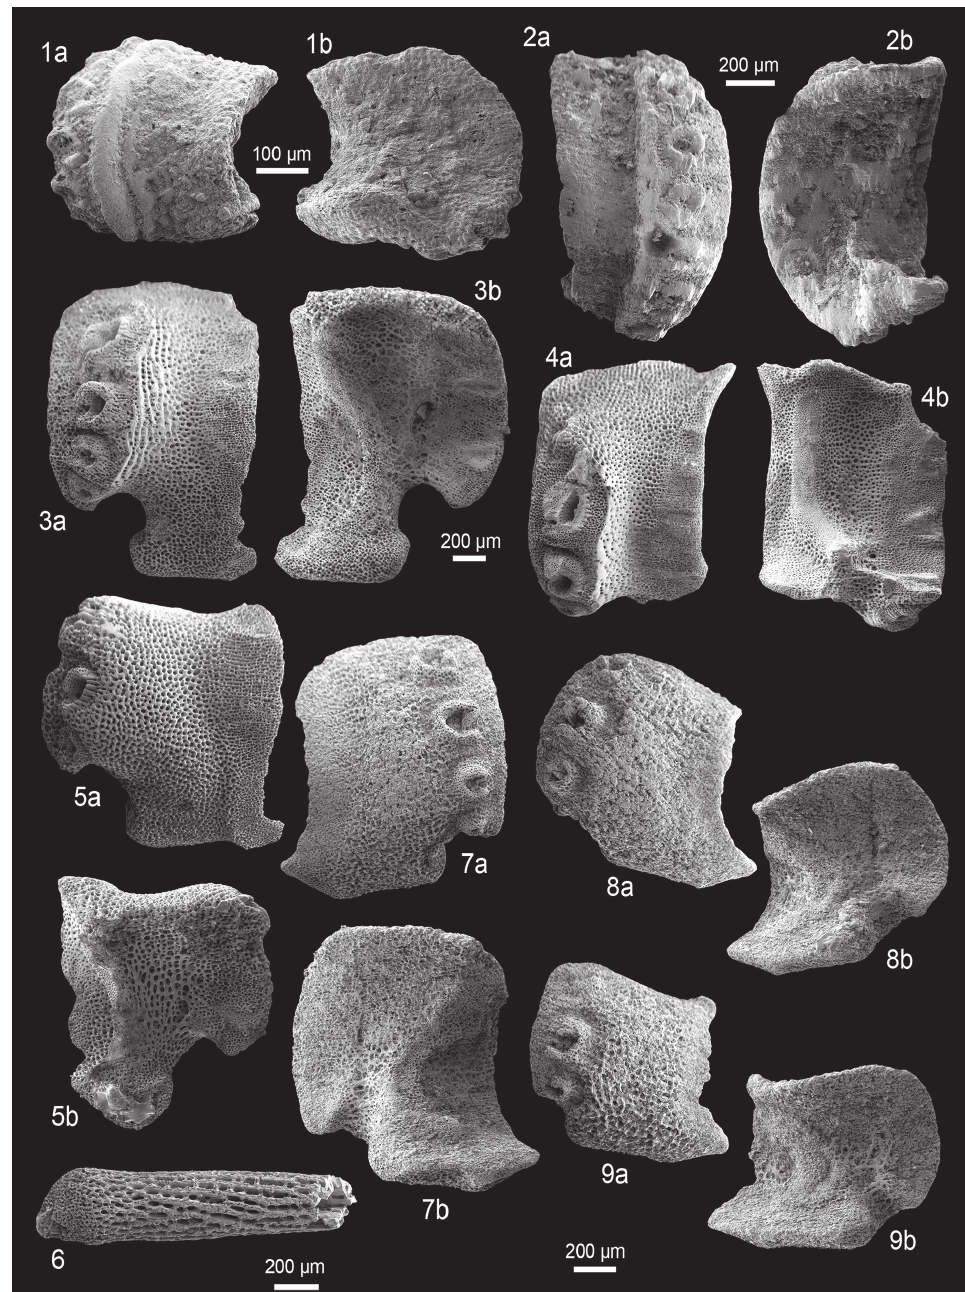
Fig. 32. Fossil skeletal plates of ophiacanthid brittle stars; lateral arm plates (LAPs) in external (a) and internal (b) views. 1. Ophiomitrella ? sp. 2 from the Bathonian (Middle Jurassic) of Jumara, India; GZG. INV.78740, median to distal LAP. 2. Ophiomitrella sp. nov. from the late Maastrichtian (Late Cretaceous) of Maastricht, the Netherlands; NHMM JJ 5104, proximal LAP. 3-6. Ophiomalleus beneficarum gen. et sp. nov. from the Callovian of Bauer-Wehrland (3), Althüttendorf (4-5) and Hohensaaten (6), Germany. 3. GZG.INV.78741 (holotype), proximal to median LAP. 4. GZG.INV.78742 (paratype), proximal LAP. 5. GZG.INV.78743 (paratype), distal LAP. 6. GZG.INV.78744 (paratype), arm spine. 7-9. Ophiomalleus stevenwilsoni gen. et sp. nov. from the latest Hauterivian (Early Cretaceous) of Sarstedt, Germany. 7. GZG.INV.78748 (holotype), proximal LAP. 8. GZG.INV.78749 (paratype), median LAP. 9. GZG. INV.78750 (paratype), distal LAP. One common scale bar per species except for